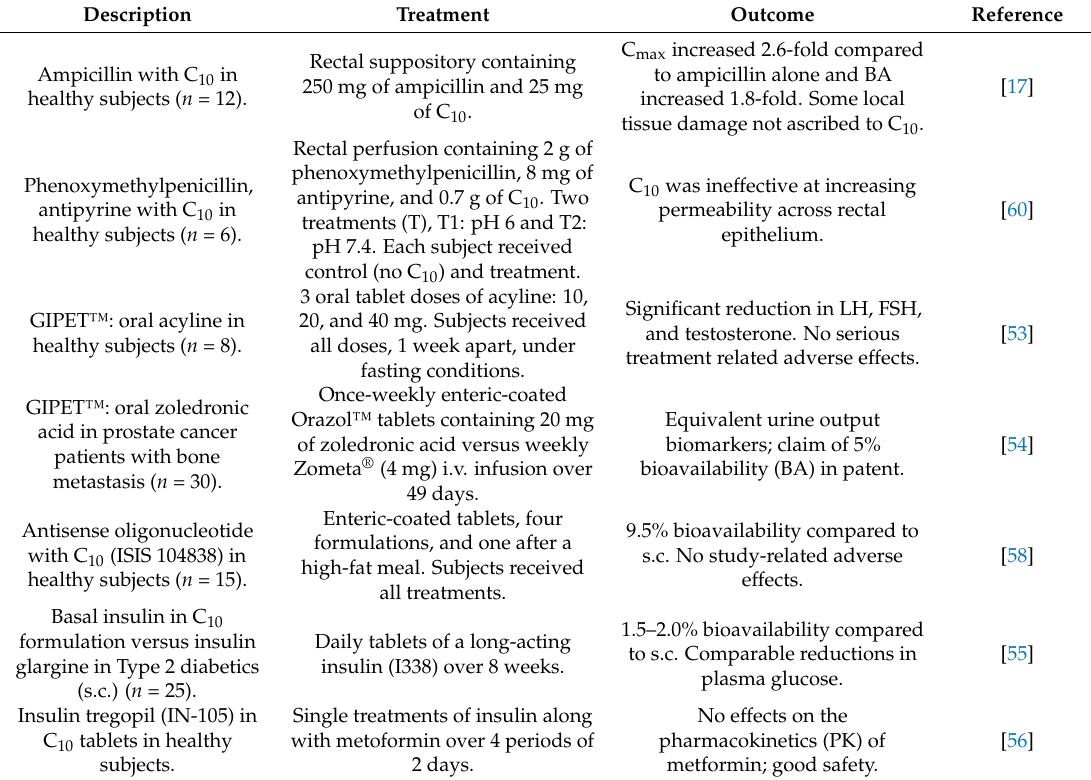
Table 1. Summary of data from selected studies in humans reported for a range of poorly permeable molecules formulated with sodium caprate (C 10